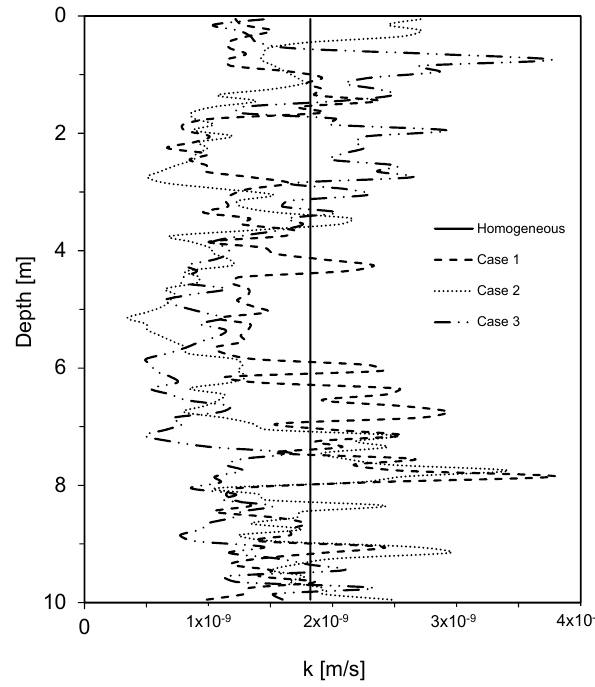
Figure 4. Realizations of spatially varying correlated consolidation coefficient profiles. All the cases are with coefficient of variation COV[k] = 0.6 and dimensionless correlation length Θ = 0.1.